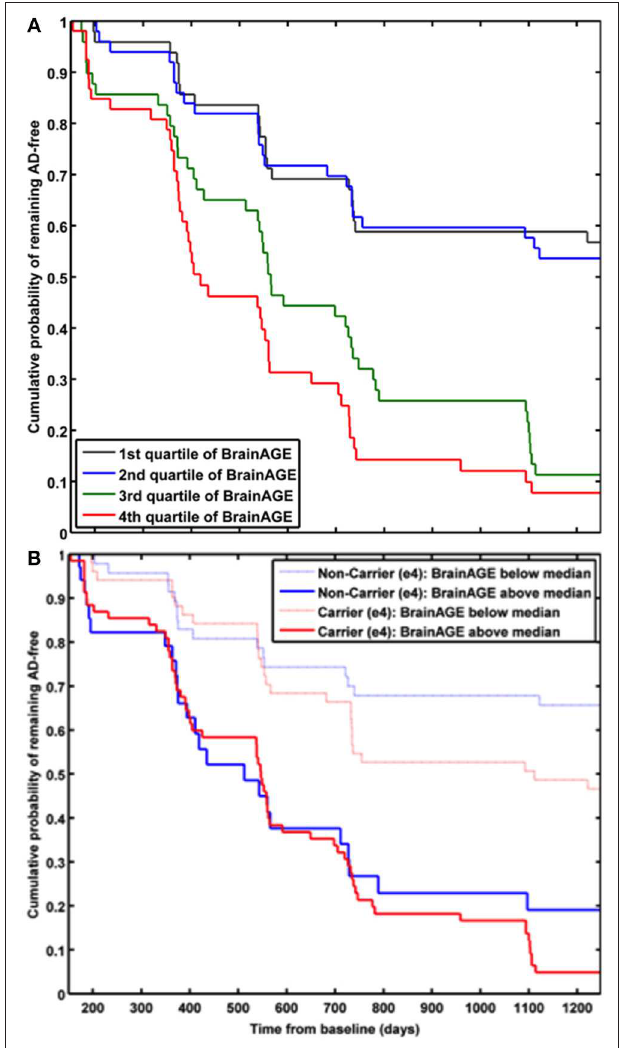
FIGURE 7 | Cumulative probability for MCI patients of remaining AD-free based. (A) Kaplan-Meier survival curves based on Cox regression comparing cumulative AD incidence in participants with MCI at baseline by BrainAGE score quartiles ( p for trend < 0.001). [Figure and legend reproduced from Gaser et al. (37), permitted under the Creative Commons Attribution License.] (B) Kaplan-Meier survival curves based on Cox regression comparing the cumulative incidence of AD incidence in ε 4-carriers [red] and ε 4-non-carriers [blue] with MCI at baseline, divided into patients with baseline BrainAGE scores below the median (light lines) and above the median (dark lines). Duration of follow-up is truncated at 1,250 days. [Figure and legend reproduced